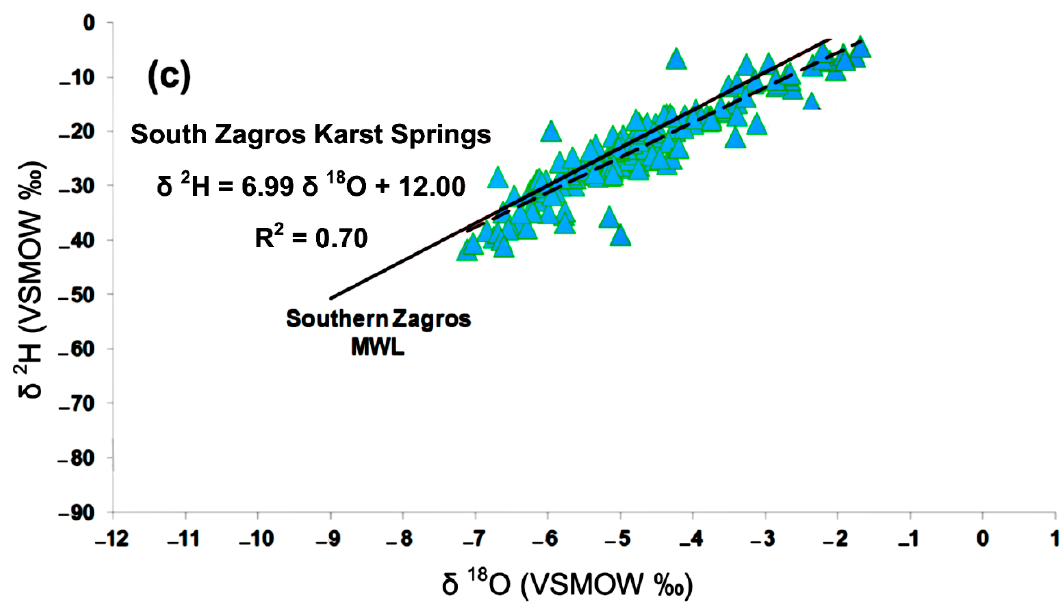
Figure 4. Karstic springs isotope values δ 18 O and δ 2 H plot on ( a ) North of Iran, ( b ) Zagros-west, and ( c ) Zagros-south MWLs.